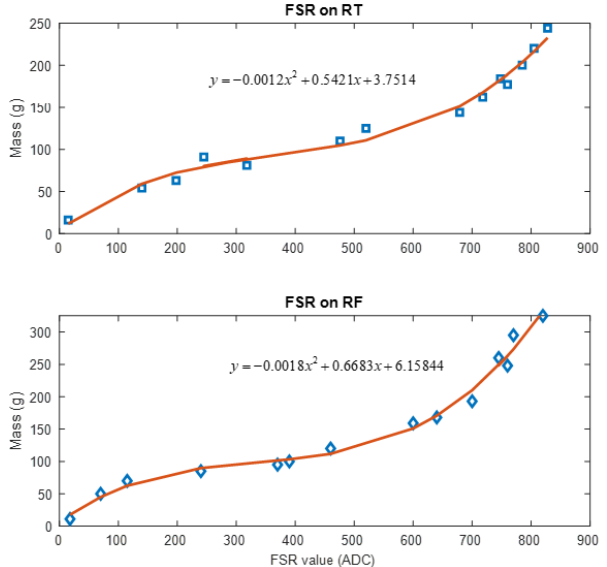
Figure 9. FSR sensors calibration on RT and RF.